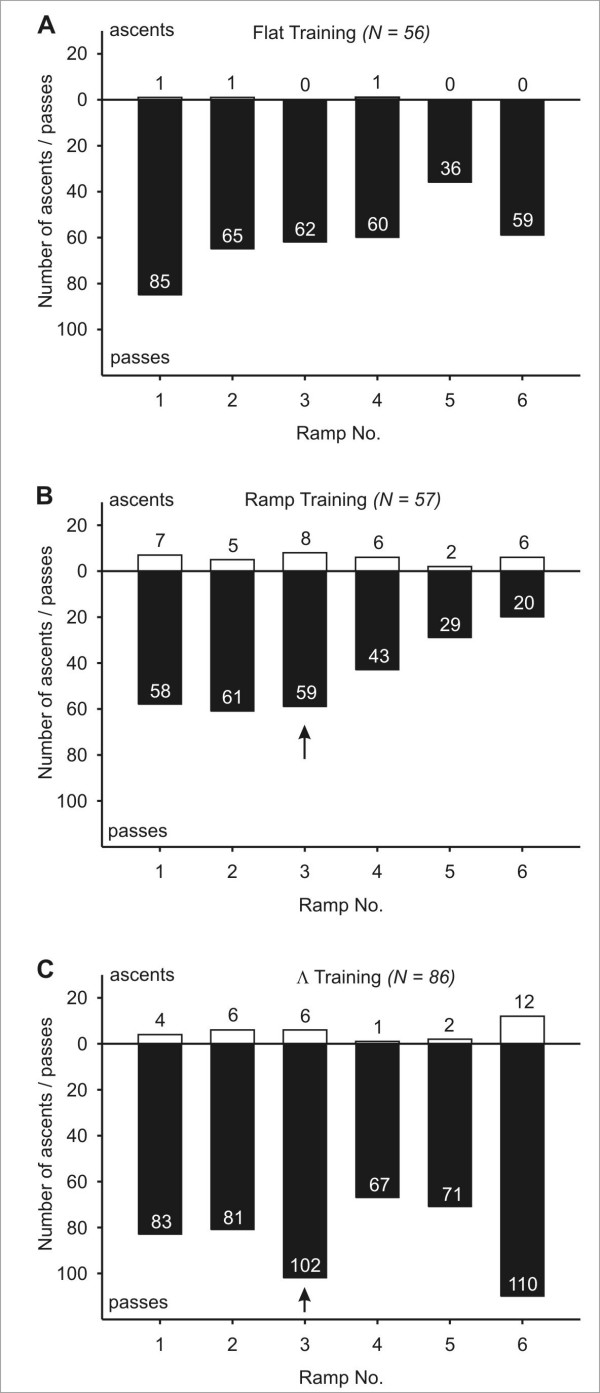
Experiment 2: Choice between different ramps. Decisions of ants to ascend (white bars) or to pass (black bars) at the six ramps that were on offer. Ramp No. 1 was located nearest to the nest, and was thus encountered first on the examined outbound runs. The black arrow in (B) and (C) indicates the ramp that corresponded to the ascending ramp during training. (A) Flat training; (B) Ramp training: the high number of ascents at ramp No. 6 did not result in a non uniform distribution (p > 0.1, χ2 homogeneity test); (C) Λ training. Flat and Λ training: Due to low expected frequencies, a non uniform distribution could not be detected.